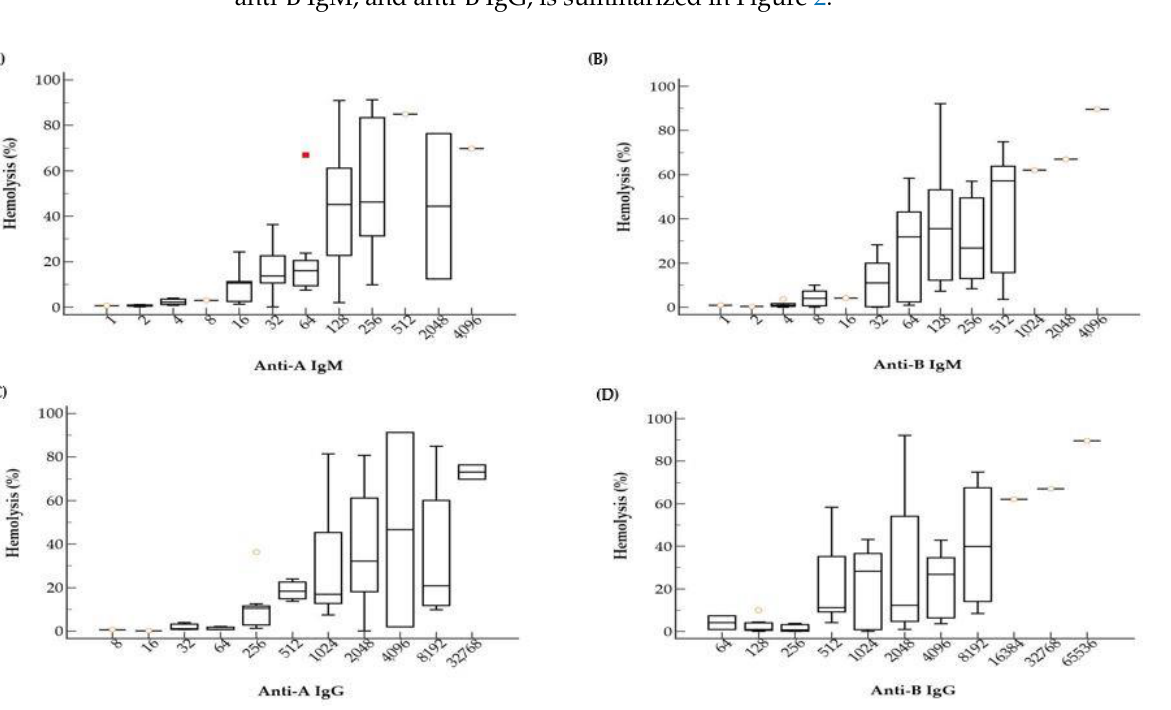
Figure 2. Hemolysis values (%) according to anti-A and anti-B isoagglutinin titers. As the titer increases, the hemolysis% also increased. There are substantial variances in hemolysis% among samples with the same isoagglutinin titers. Box and whiskers plots indicate hemolysis% according to anti-A IgM ( A ), anti-B IgM ( B ), anti-A IgG ( C ), and anti-B IgG ( D ) titers. The red square indicates an outlier.